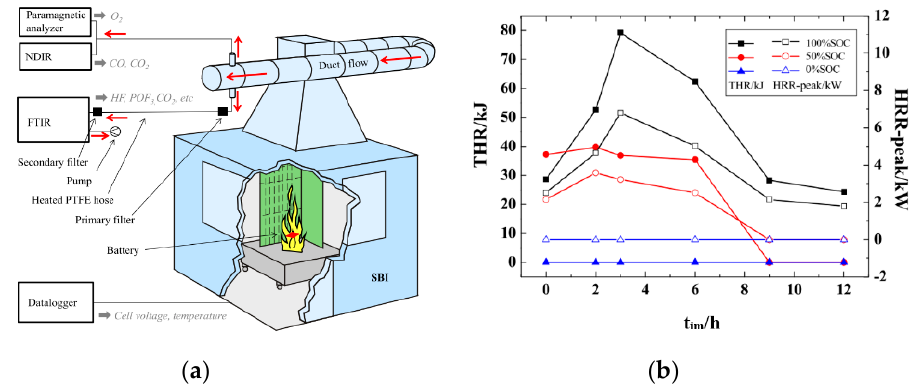
Figure 7. ( a ) Schematic illustration of experimental setup [69]; ( b ) change in total heat release (THR) and heat release rate (HRR) peak with different immersion times (tim) [70].